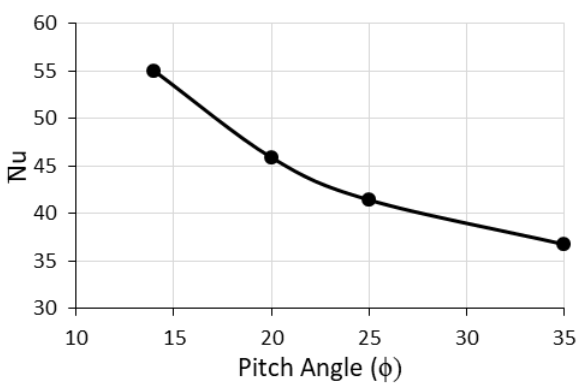
Fig. 11. Mean Nusselt number with pitch